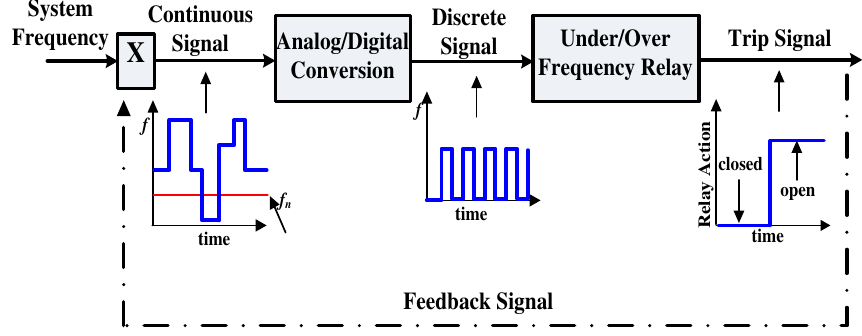
Fig. 5 A simplified block diagram of digital OUFR